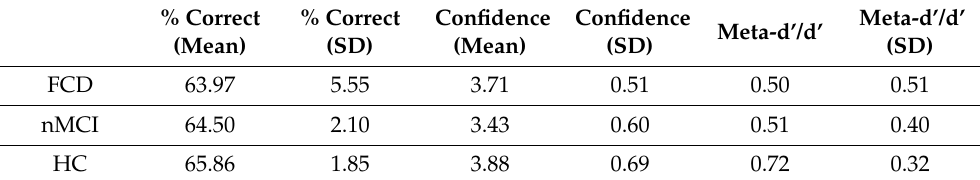
Table 3. Performance accuracy, confidence and Meta-d’/d’ on the perceptual